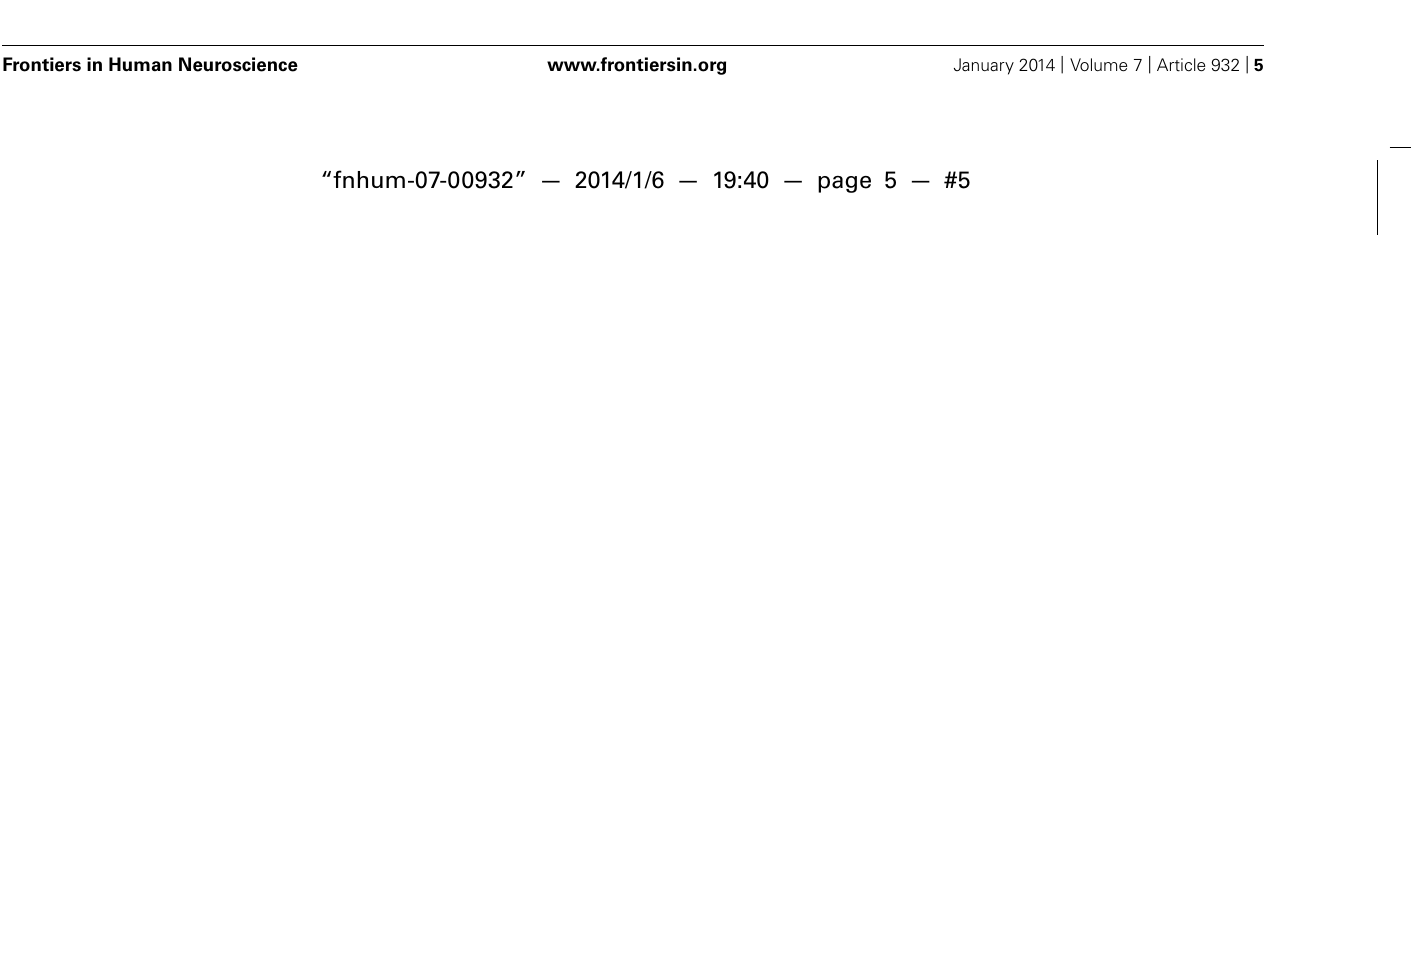
gyri, and cuneus for each of the four group of participants. Stimulus onset is at 0 ms.Time windows of significant group differences are marked by